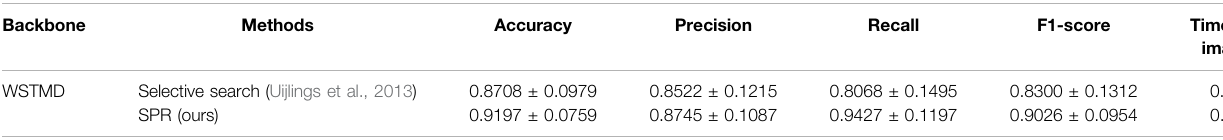
TABLE 2 | Performance comparison of different region proposal methods.